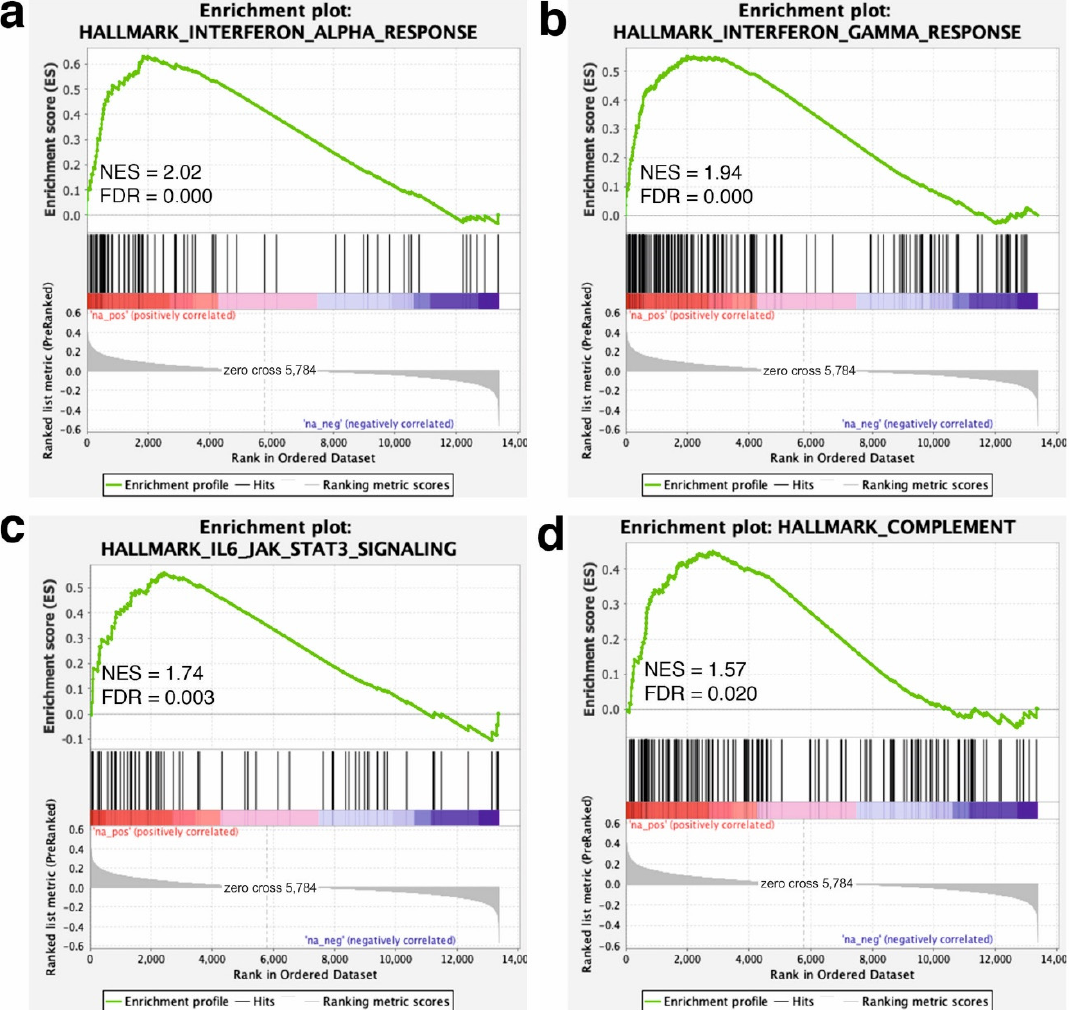
Figure 2. Gene set enrichment analysis (GSEA) plot (score curves) for enriched hallmarks. The GSEA analysis was performed with the hallmarks gene sets of GSEA Molecular Signatures Database. The “Signal-to-Noise” ratio (SNR) statistic was used to rank the genes per their correlation with the dietary GP supplementation (red) or the un-supplemented CTR phenotype (blue). The heatmap on the right side of each panel visualize the genes mostly contributing to the enriched gene set. For the fully detailed list, see Supplementary Table S3. The green curve corresponds to the Enrichment Score (ES) curve, which is the running sum of the weighed ES obtained from the GSEA software, while the Normalized Enrichment Score (NES) and the corresponding p -value are reported within each graph. Panels ( a – d ) denote the most enriched (significant) pathways (i.e., gene sets).